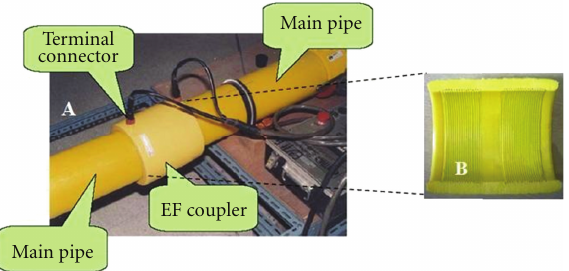
Figure 1: (A) Electrofusion (EF) joining of two polyethylene (PE) pipes using EF coupler. (B) Cross-section of EF coupler including heating wires.